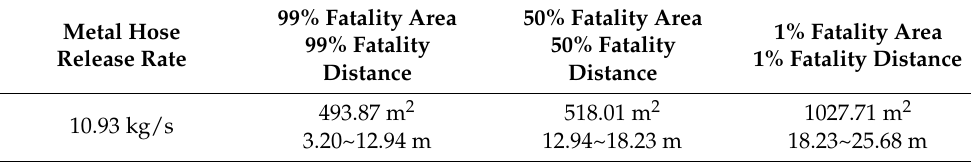
Table 6. Fatality area and distance from jet fire point according to metal hose release rate.